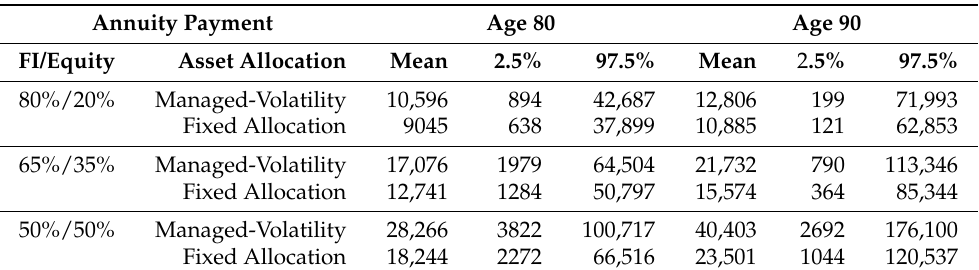
Table 9. Annuity Payments at Different Initial Allocations at Age 80 and